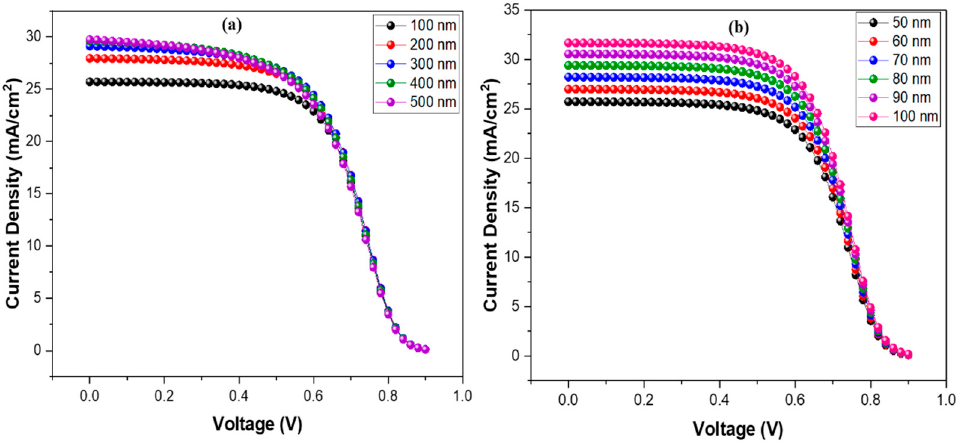
Figure 3. ( a ) Current-density comparison as absorber layer thickness varies; and ( b ) current-density comparison as HTM layer thickness varies.